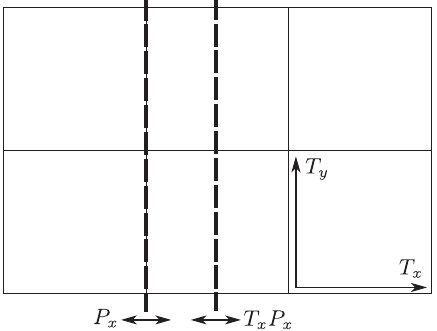
FIG. 1. Illustration of the operations generating the d ¼ 2 space group pm . A square lattice, which is invariant under pm symmetry, is shown to aid visualization. T and T are trans- x y lations by one lattice constant along the x and y axes, respectively. P is a reflection, with the axis indicated by the x left-hand vertical dashed line. The group pm has two types of P reflection axes, with P being of one type and T being of the x x x P other type. The reflection axis for T is shown as the right- x x hand vertical dashed